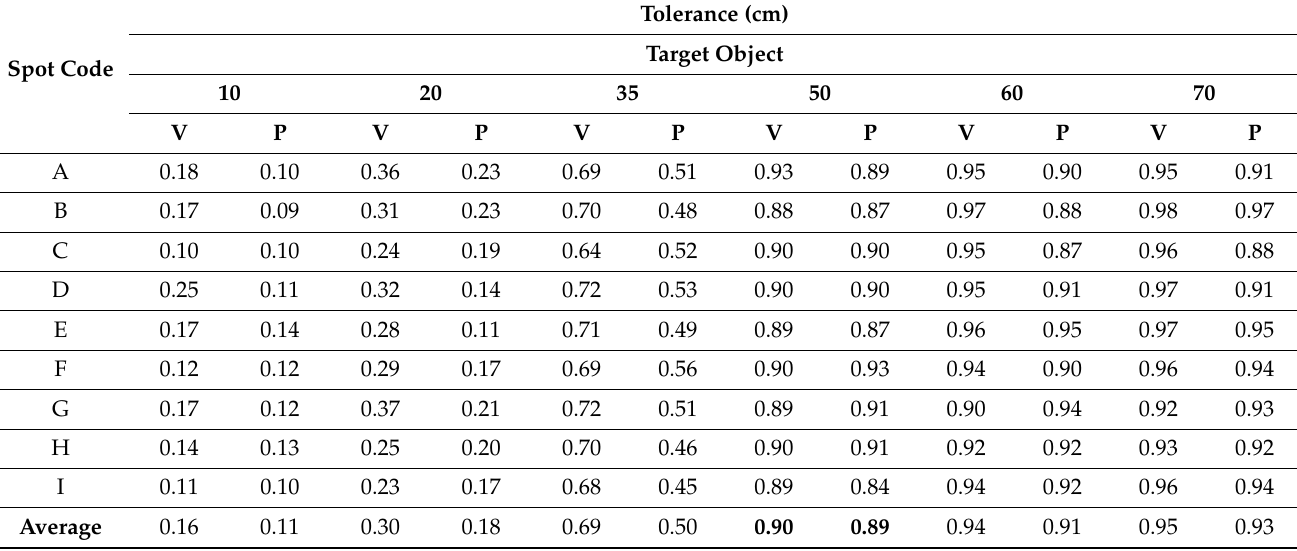
Table 5. Results of accuracy using tolerance for vehicle and pedestrian in each